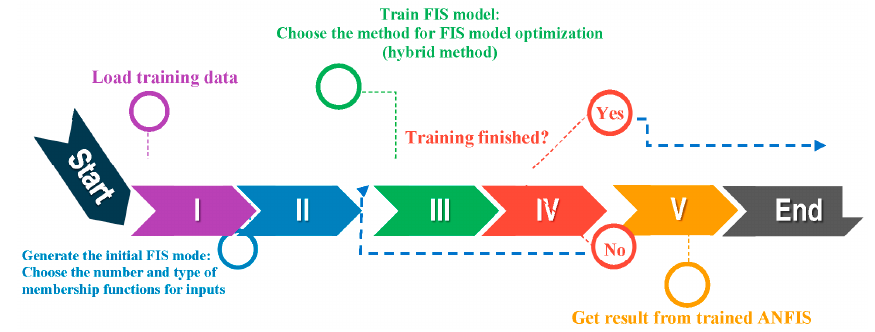
Figure 12. ANFIS training process flowchart.